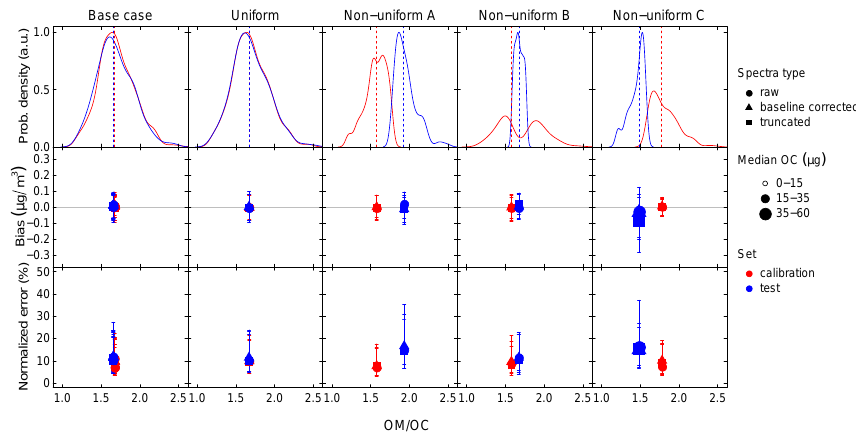
Figure 5. The probability distribution of OM / OC and bias and normalized error (with the interquartile range shown by error bars) in the calibration (red) and test (blue) sets for five calibration cases: the Base case, the Uniform OM / OC case and three Non-uniform OM / OC cases. Vertical lines on the probability distributions are the color-coded median of the OM / OC